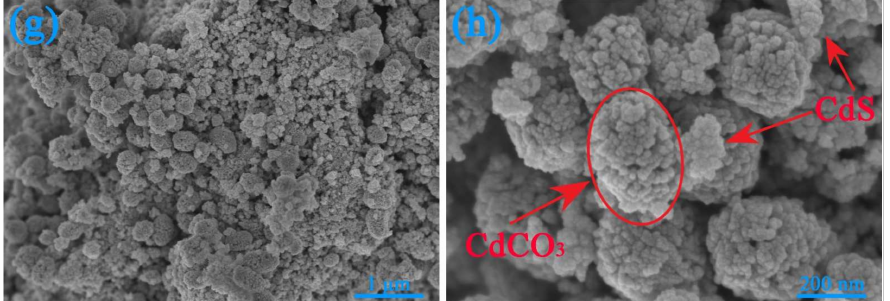
Figure 2. SEM images of CdS ( a , b ), CdCO 3 ( c , d ), 5-CdS/CdCO 3 ( e , f ) and 5-CdS/CdCO 3 @SDS ( g , h ).